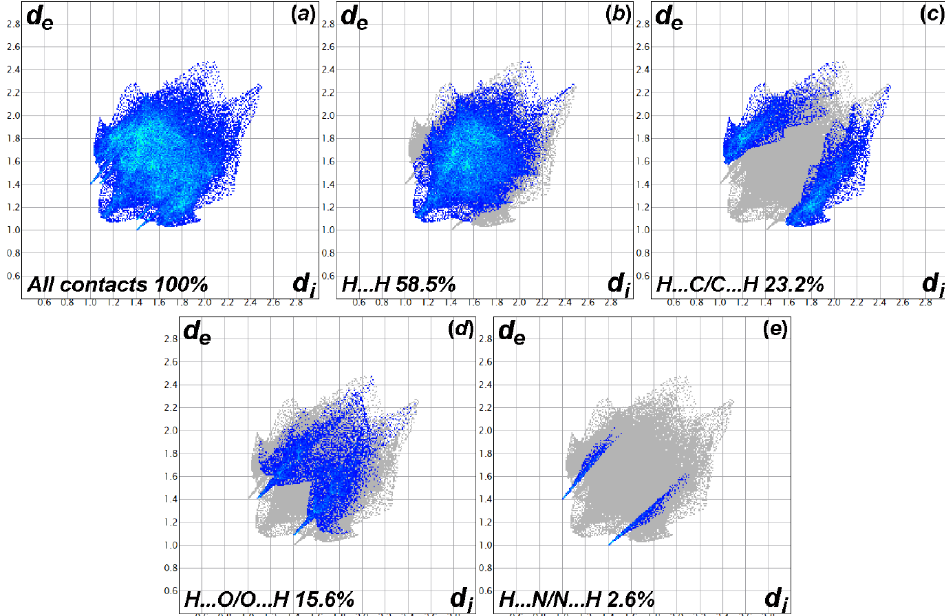
Figure 4. The full two-dimensional fingerprint plot from the corresponding, plotted over the d norm range from − 0.155 to +1.157 arbitrary units for the benzoxazine (I), showing ( a ) all interactions and those delineated into ( b ) H···H, ( c ) H···C/C···H, ( d ) H···O/O···H, and ( e ) H···N/N···H interactions. The d i and d e values are the closest internal and external distances (in Å) from given points on the Hirshfeld surface.